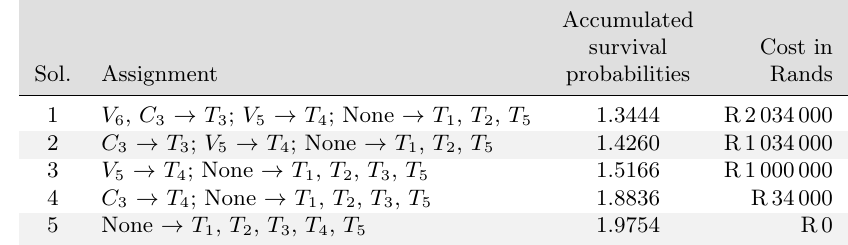
Table 5: The set of approximately Pareto optimal solutions obtained by the NSGA II for stage t 20 of the scenario, using the same solution indices as in Figure